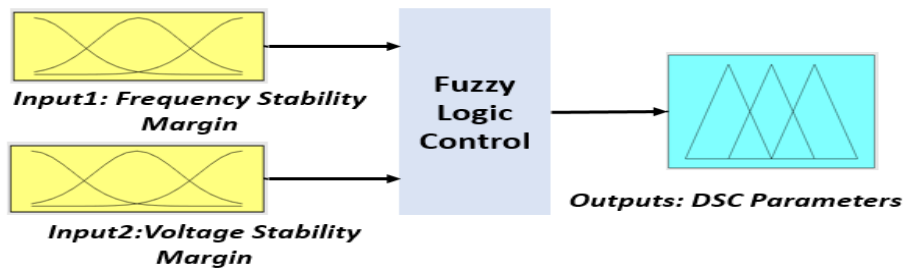
Figure 6. Input–output relations of the proposed fuzzy logic tuner.